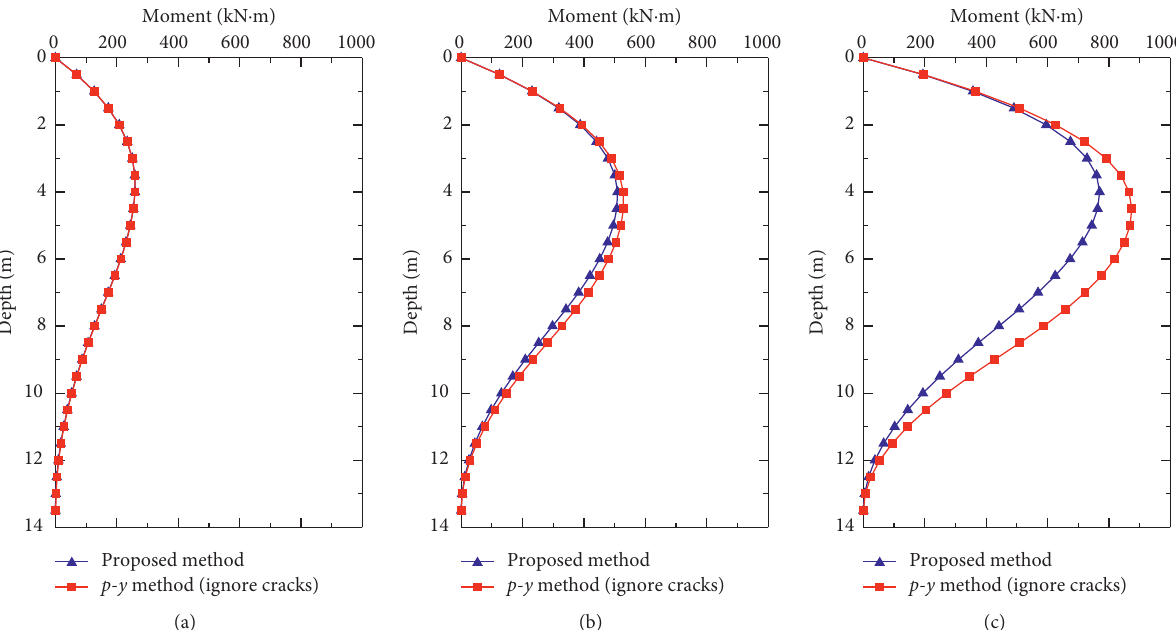
Figure 10: Influence of cracking on the bending moment: (a) load � 150kN; (b) load � 270kN; (c) load �